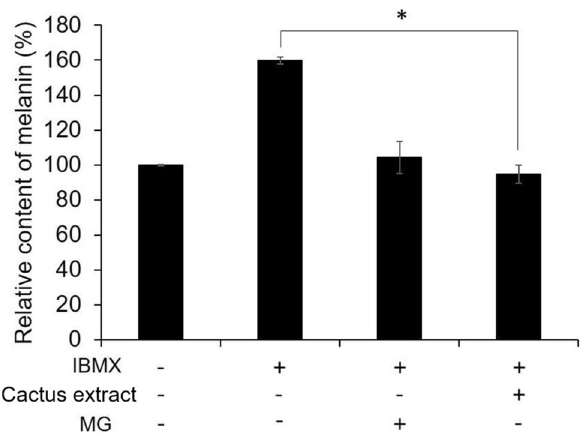
Figure 5. The effect of cactus extract (flesh) on melanin production content in B16-F10 cells. All data are presented as the mean ± S.D. of three independent experiments. * P < 0.05, ** P < 0.01 compared with control group.